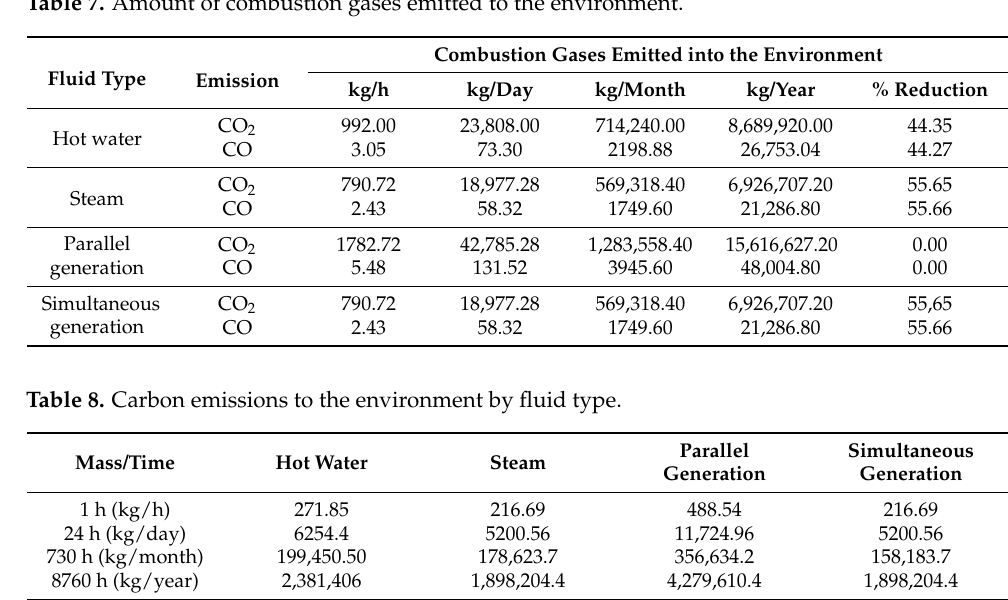
Table 7. Amount of combustion gases emitted to the environment.